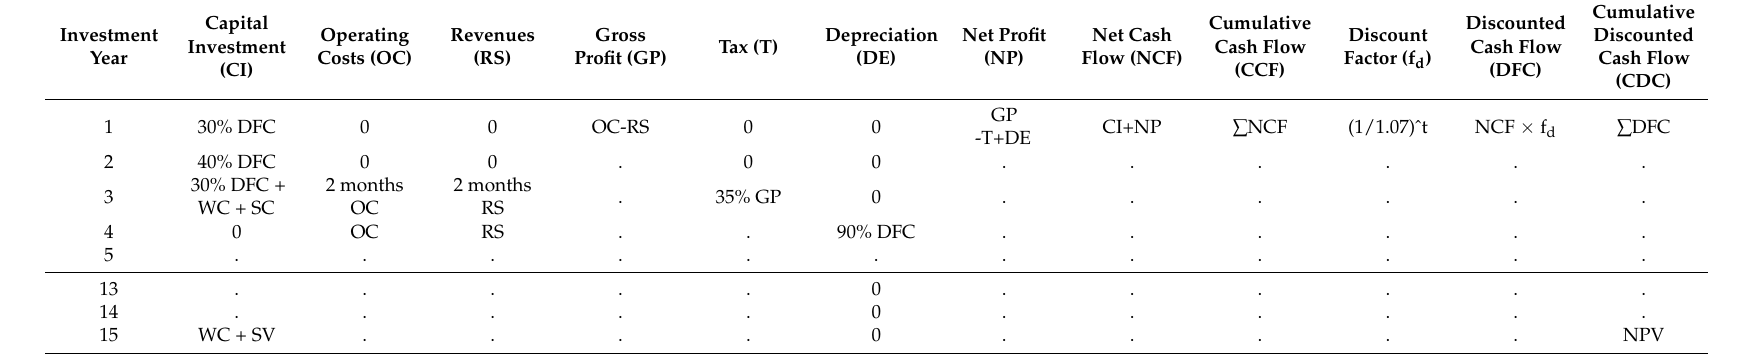
Table 2. The calculation of cash flow for soybean oil extraction